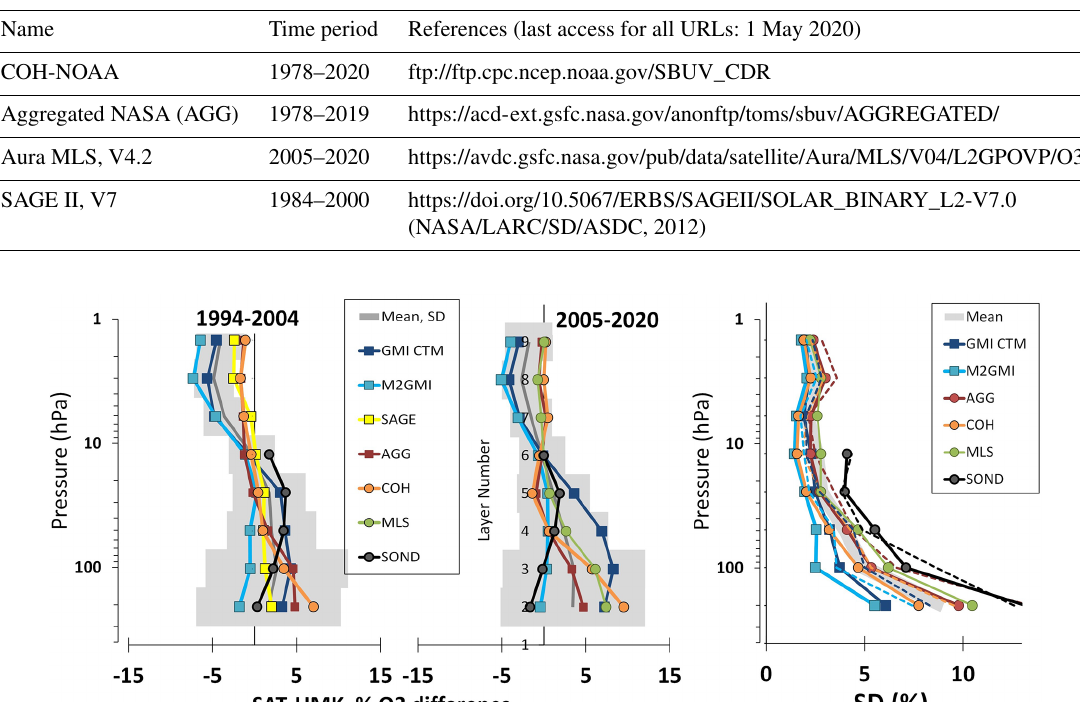
Table 3. Satellite ozone profile records used for comparisons with Umkehr records. The time of observational (combined) records and links to the archived records are included for reference.